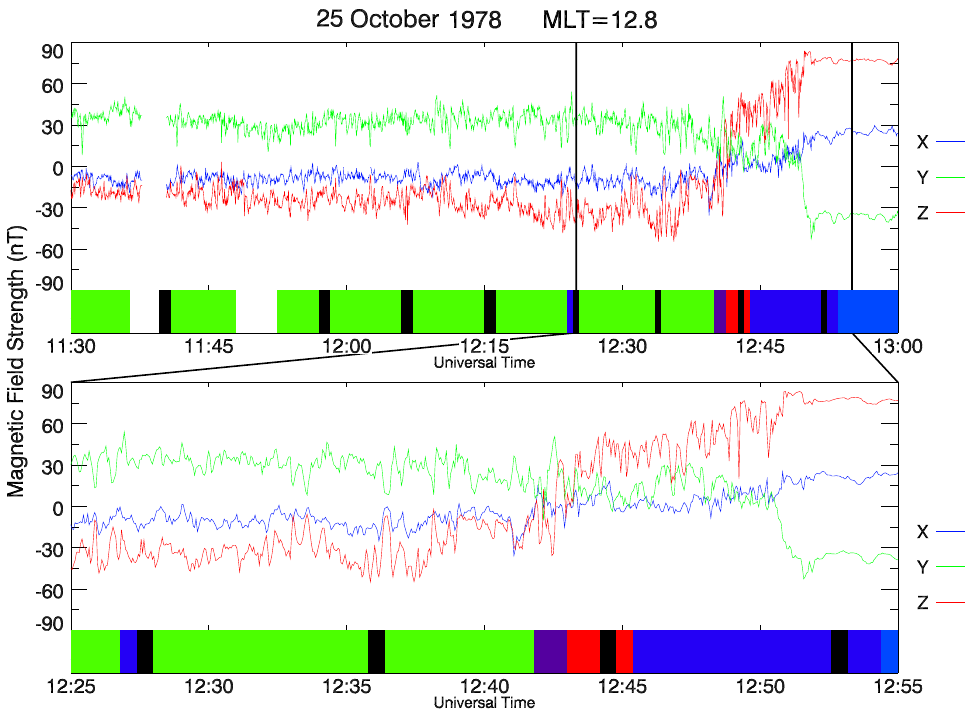
Fig. 4. The top plot shows the three components of the ISEE-1 measured magnetic field on 25 October 1978 (Day298) from 11:30 to 13:00UT. On the bar just below, the occurrence of various pitch-angle distributions (PADs) of the types presented in Fig. 2 is depicted. (Northern hemispheric PADs are those regions of green shading and the black shaded regions are periods of bad or missing data.) The bottom plot is a detailed blowup of the above plot from 12:25 to 12:55UT. Table 1. ISEE-1 positions at the beginning and end of the expanded time intervals of the magnetopause crossings. Note X GSE = X GSM